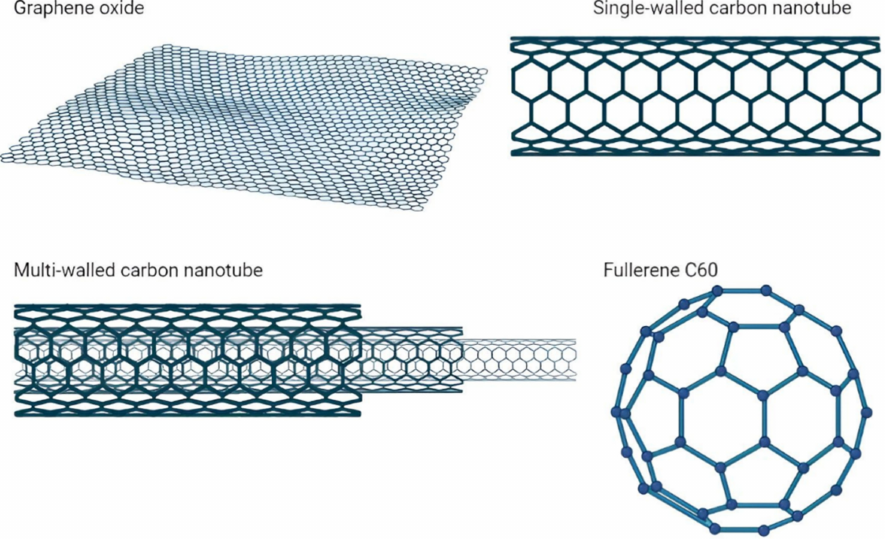
Figure 1. Main types of carbon